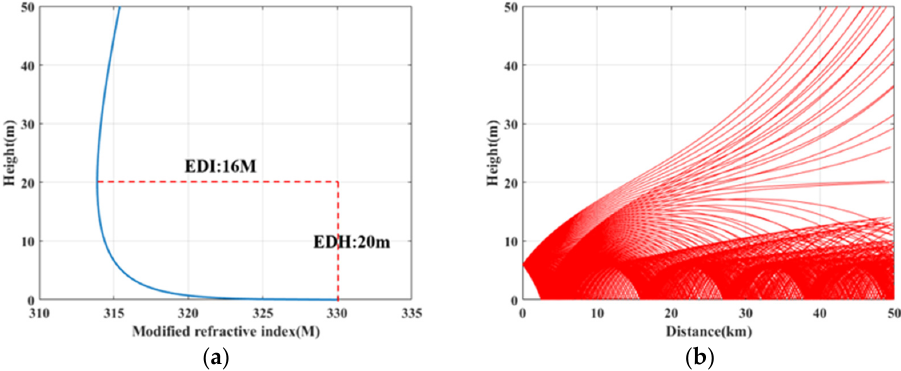
Figure 8. A typical ED profile showing its EDH and EDI ( a ) and the EM-wave propagation trajectory for the typical ED profile ( b